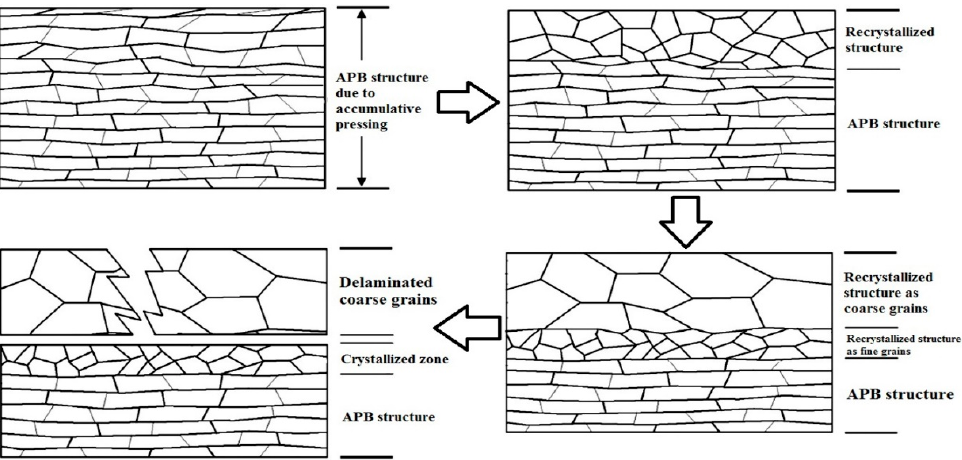
Figure 11. Drawings of the sliding wear of APB composite samples vs. different steps of deformation and recrystallization mechanism.